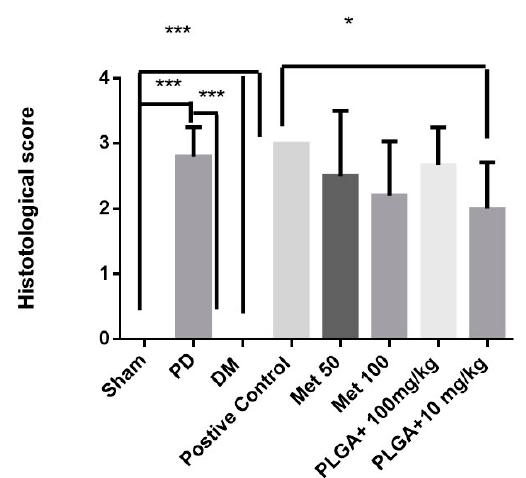
Figure 3. Histopathological score. Sham Group, PD group without DM; DM group without PD; DM group with PD: positive control; Met 50; Met 100; PLGA + 10 mg/kg Met; PLGA + 100 mg/kg. * p < 0.05; *** p < 0.001. (Kruskal–Wallis test followed by Dunn’s test).